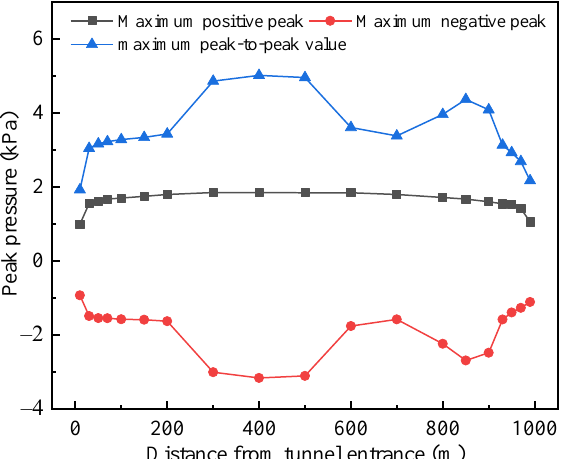
Figure 17. Distributions of maximum peak pressures along tunnel vault in Stage II.